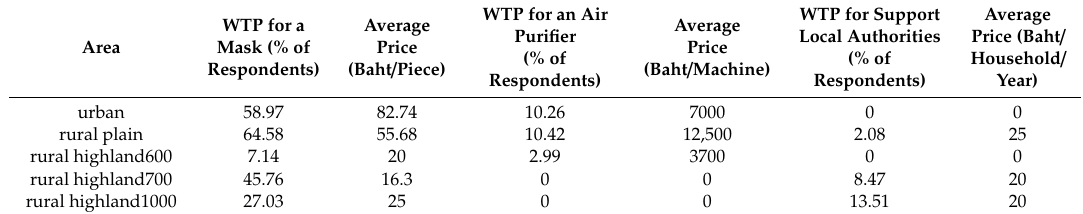
Table 4. WTP for self-protection and air pollution